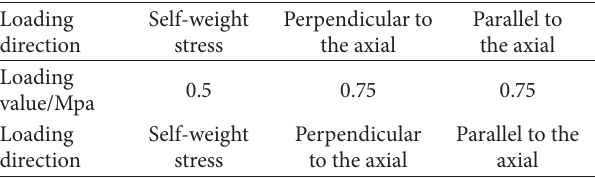
Table 4: The loading value of the